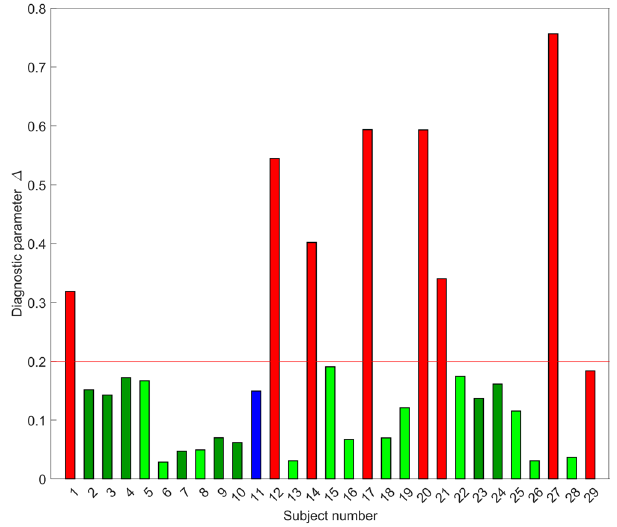
Fig. 5 | In vivo light scattering spectroscopic differentiation of bile duct malignancy in29 subjects. The colorof the bars represents theclinicaldiagnosis. Light green subjects with benign bile duct, dark green — benign with in fl ammation, blue — low-gradedysplasia,andred — high-gradedysplasiaorcancer.Thebarheights represent the light scattering spectroscopy based diagnostic parameter. The red line at 0.2 represents the high-grade dysplasia and cancer diagnostic cutoff established earlier in pancreatic cysts 33